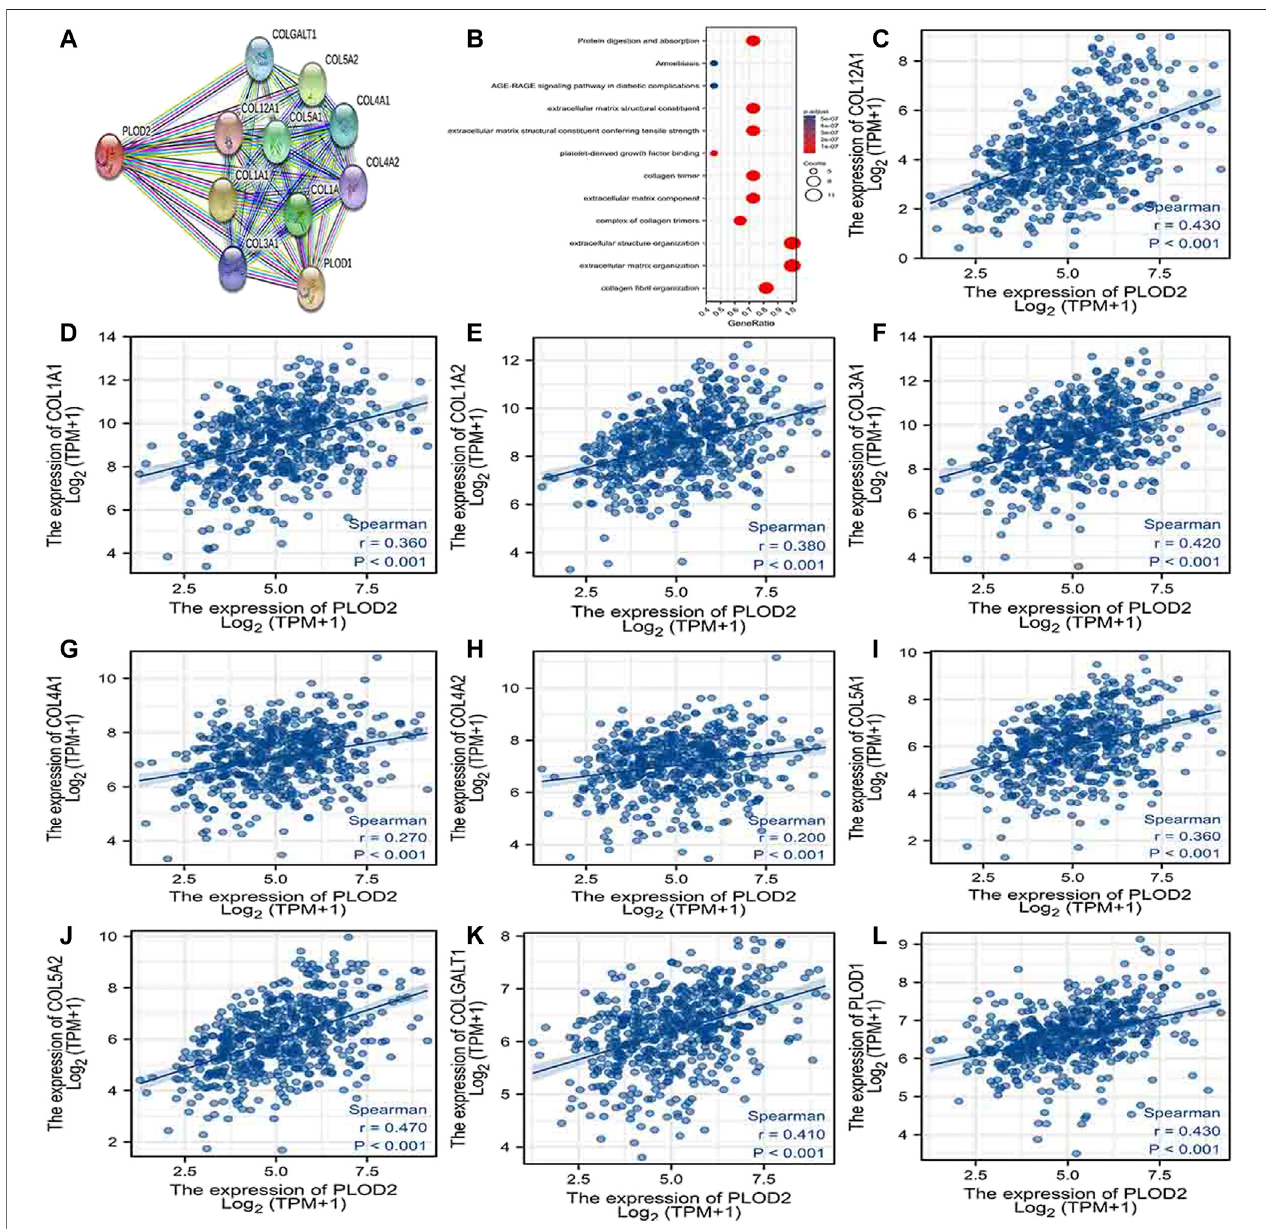
FIGURE 7 | PLOD2 PPI network and biological function annotation. (A) Network of PLOD2 and its co-expressed genes. (B) Functional enrichment analysis of 10 network genes. PLOD2 was associated with collagen fi bril organization, extracellular matrix organization, and extracellular structure organization. These genes are involvedinproteindigestionandabsorption,amoebiasis,andAGE-RAGEsignalingindiabetes. (C – L) CorrelationsbetweentheexpressionofPLOD1andco-expressed genes in lung adenocarcinoma. COL12A1, collagen alpha-1 (XII) chain; COL1A1, collagen alpha-1(I) chain; COL1A2, collagen alpha-2(I) chain; COL3A1, collagen alpha-1(III) chain; COL4A1, collagen alpha-1(IV) chain; COL4A2, collagen alpha-2(IV) chain; COL5A1, collagen alpha-1(V) chain; COL5A2, collagen alpha-2(V) chain; COLGALT1, procollagen galactosyltransferase 1; PLOD1 : procollagen-lysine,2-oxoglutarate 5-dioxygenase